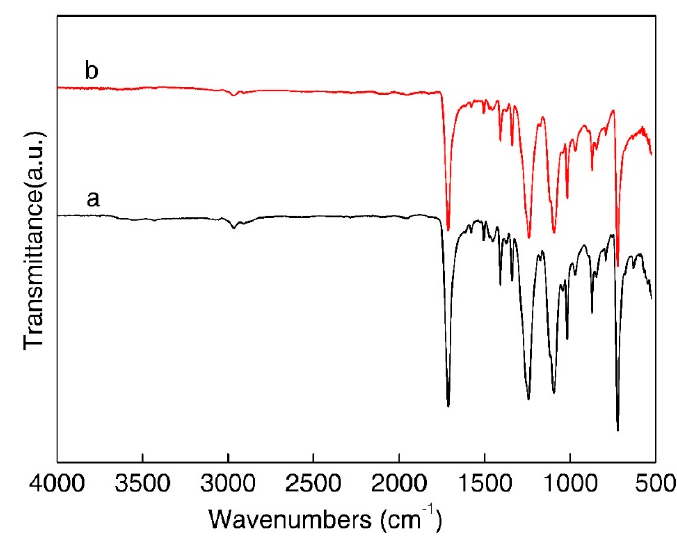
Figure 6. FTIR spectra of the polyester fibers (a) before and (b) after silver plating.